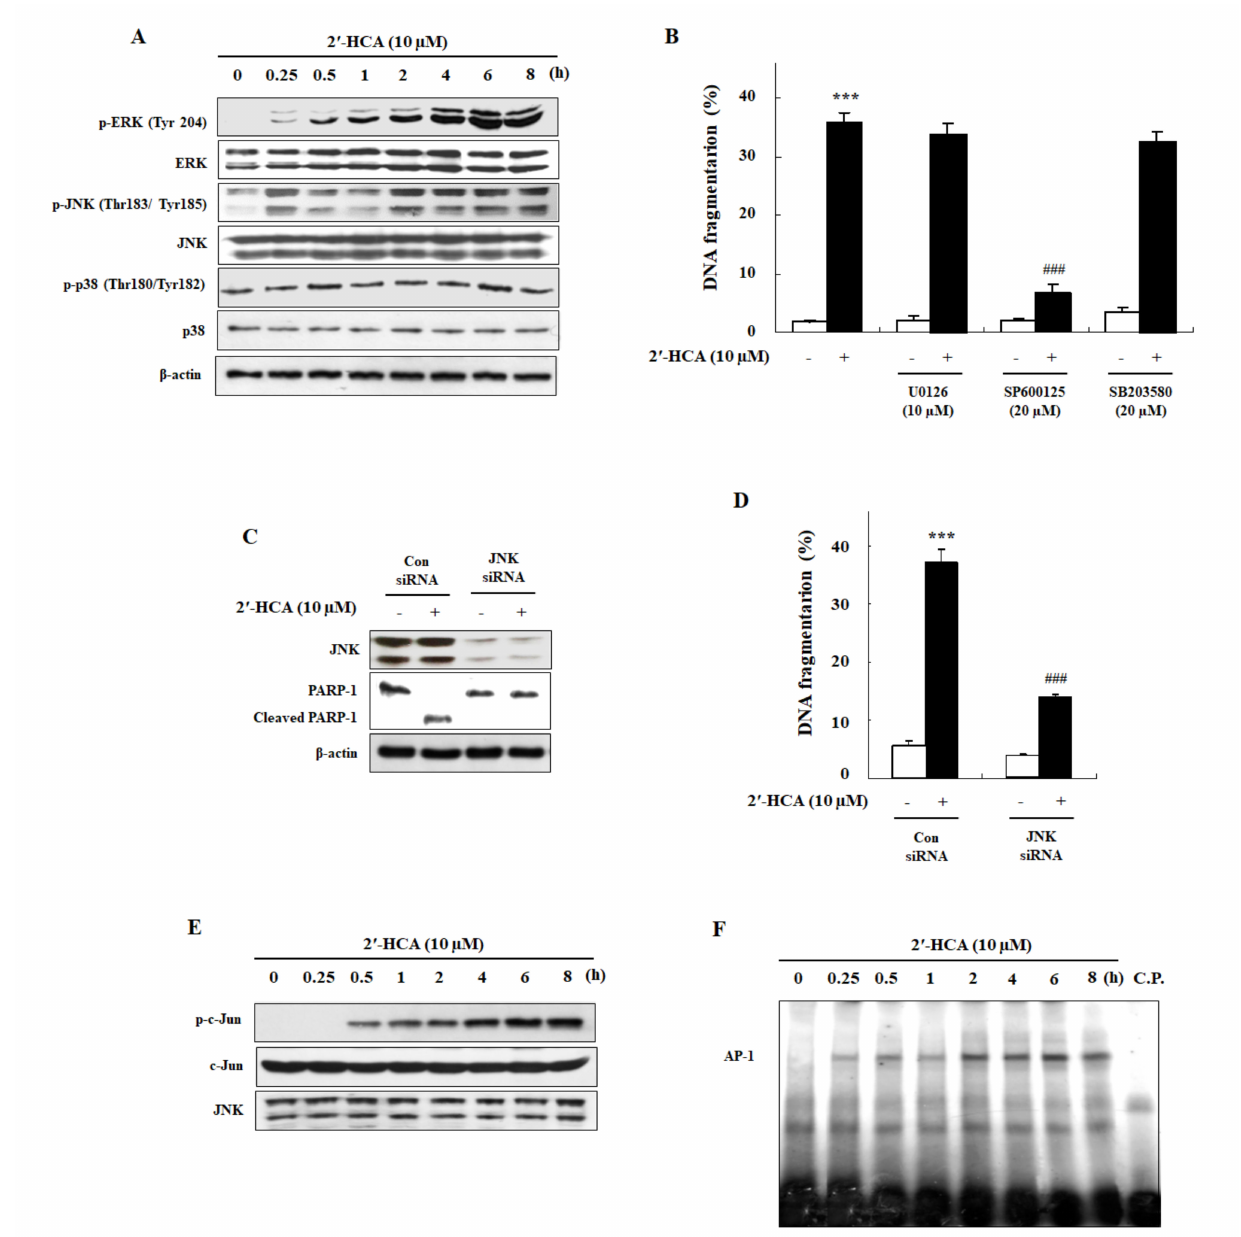
Figure 5. Effect of 2 (cid:48) -HCA on MAPK activation in HL-60 cells. ( A ) Representative western blots showing changes in the protein levels of p-ERK1/2, ERK1/2, p-JNK, JNK, p-p38 MAPK, and p38 MAPK after treatment with 10 µ M 2 (cid:48) -HCA for the indicated times in HL-60 cells. β -actin was used as an internal control. ( B ) After pretreatment with MAPK inhibitors (U0126, ERK1/2 inhibitor; SP600125, JNK inhibitor; SB203580, p38 MAPK inhibitor) for 1 h, HL-60 cells were treated with 10 µ M 2 (cid:48) - HCA for 8 h, and the extent (%) of DNA fragmentation was determined by DAPI assay. ( C , D ) JNK siRNA-transfected HL-60 cells were treated with 10 µ M 2 (cid:48) -HCA for 8 h. The levels of protein expression and DNA fragmentation were determined by western blotting and DAPI assay, respectively. ( E ) HL-60 cells were treated with 10 µ M 2 (cid:48) -HCA for the indicated times, and JNK activity was determined by JNK kinase assay. ( F ) Nuclear extracts were prepared from 2 (cid:48) -HCA-treated HL-60 cells and analyzed for AP-1 DNA-binding activity by EMSA. A competition experiment using a 5-fold excess of cold oligonucleotides (C.P.) indicated that DNA binding was specific. Data are presented as the mean ± SD of three independent experiments. *** p < 0.01 vs. control group, ### p < 0.001 vs. 2 (cid:48) -HCA-treated